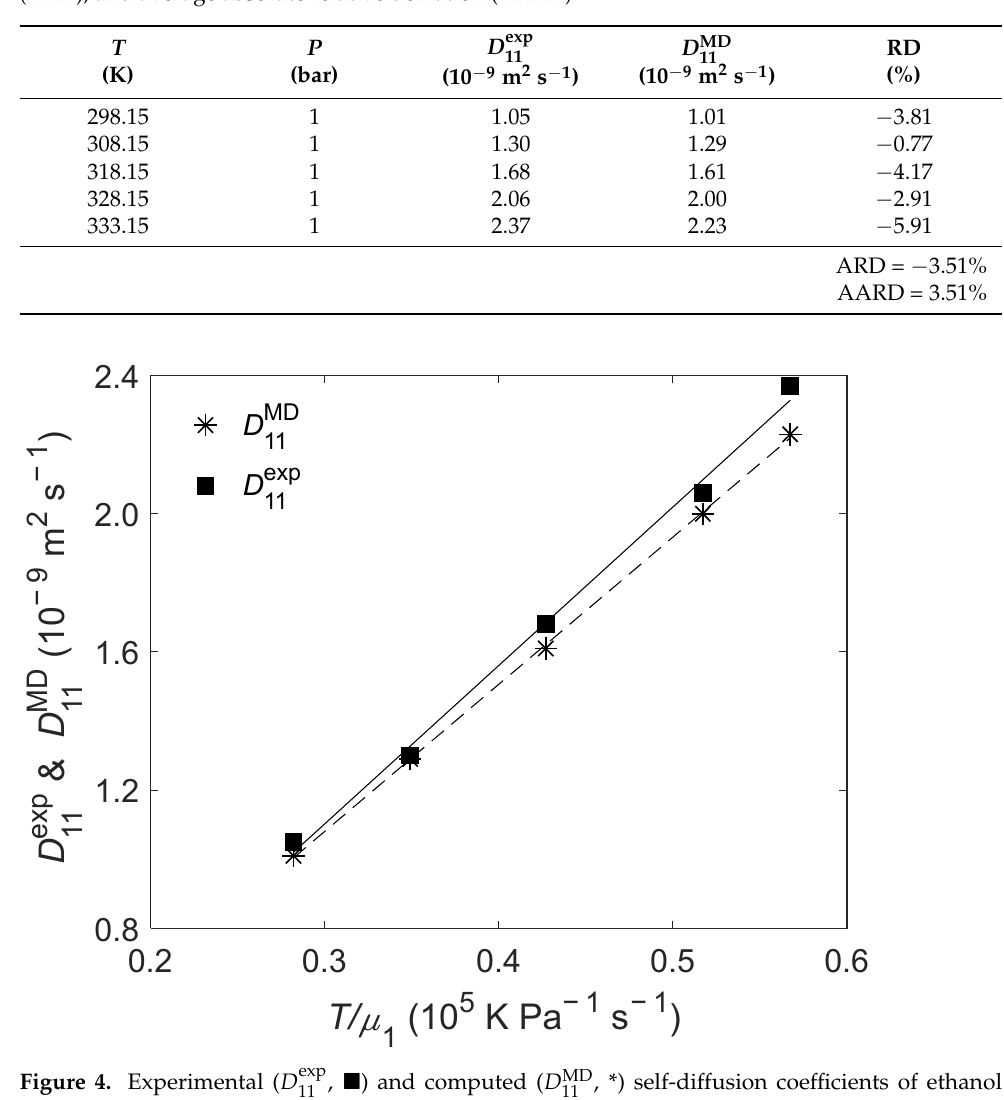
Table 3. Experimental ( D exp ) and computed ( D MD ) self-diffusion coefficient of ethanol. The computer simulations used σ OH = 0.306 nm for ethanol, and the calculated diffusivities were evaluated in comparison with experimental data in terms of the relative deviation (RD), average relative deviation (ARD), and average absolute relative deviation (AARD).